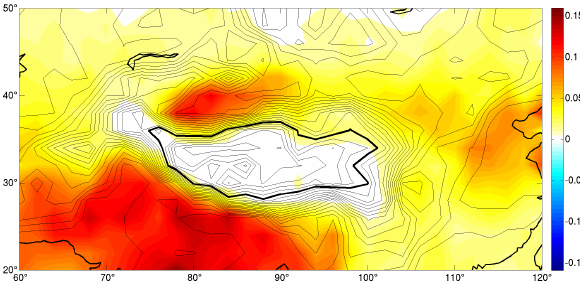
Fig. 10. Vertically averaged total heating rate anomalies due to aerosols between 0 and 8kma.m.s.l. in K/day. Simulation with MODIS surface albedo. The thick lines indicate coasts and the Ti- betan